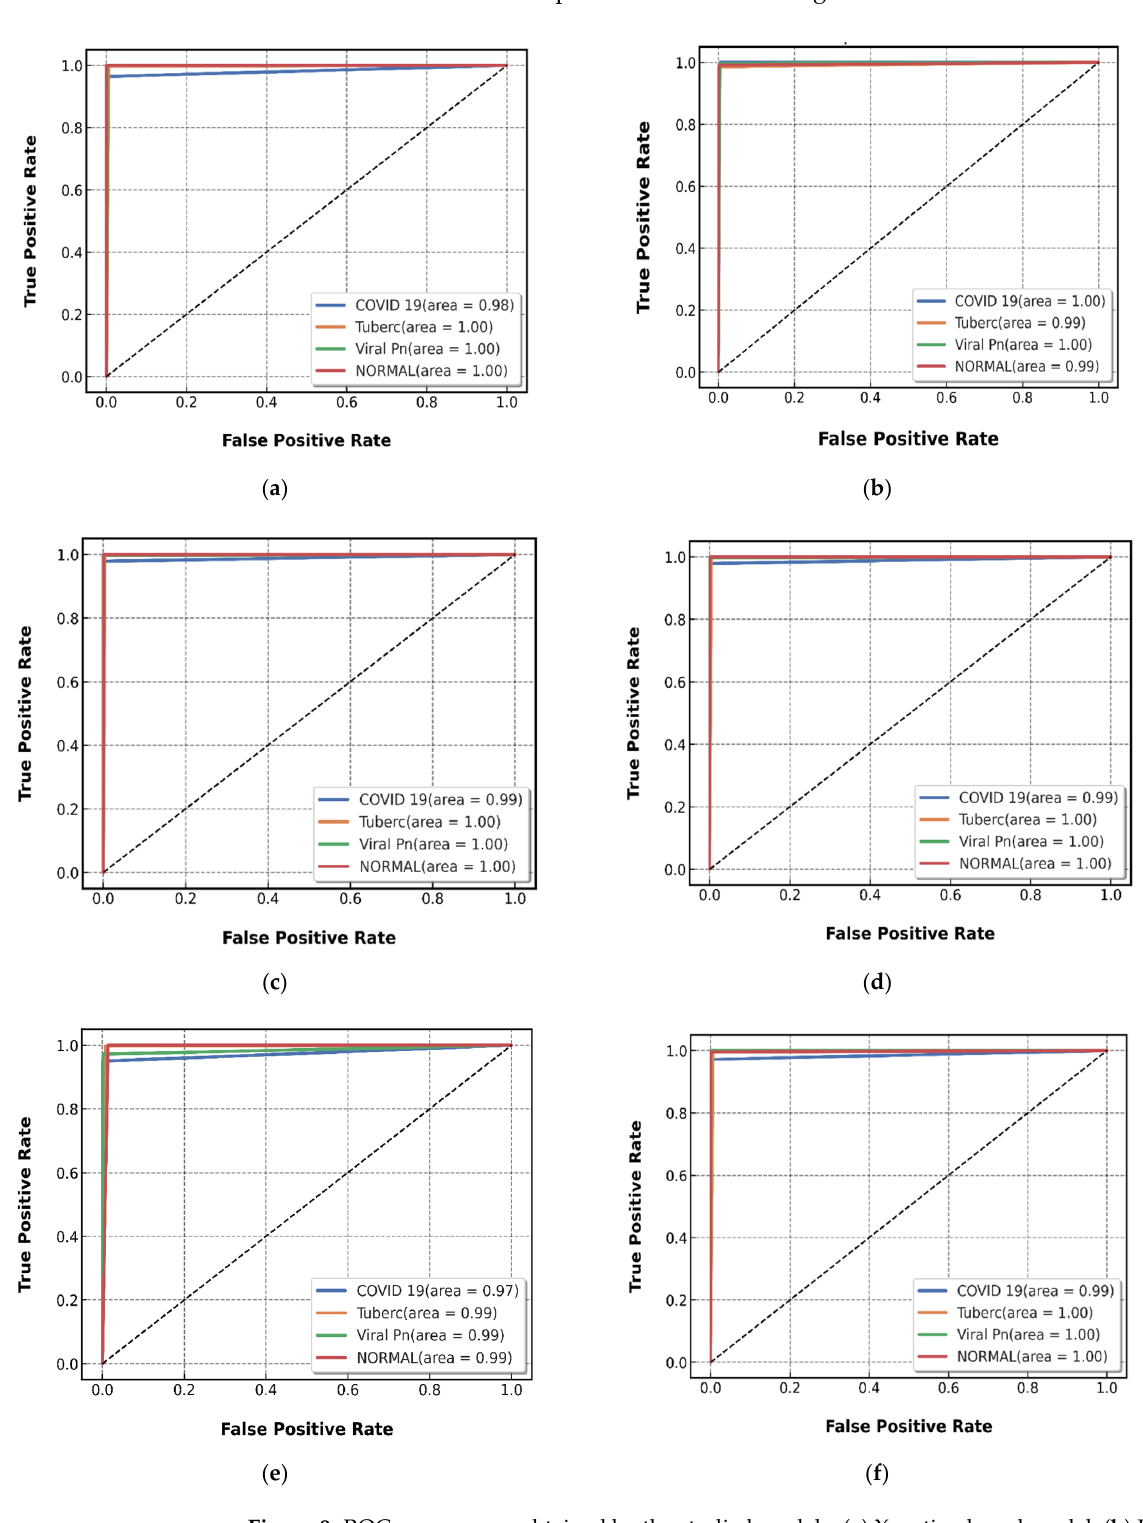
Figure 9. ROC curves were obtained by the studied models. ( a ) Xception based model, ( b ) Inception V3 based model, ( c ) InceptionResNet V2 based model, ( d ) ResNet50 V2 model, ( e ) MobileNet V2 based model, ( f ) DenseNet201 based model.